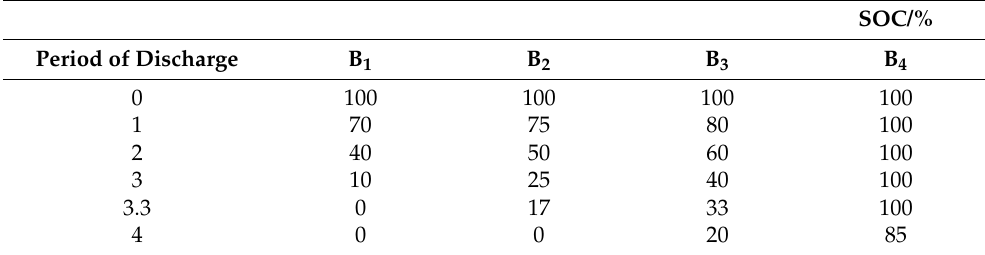
Table 1. Traditional redundant battery management algorithm discharge